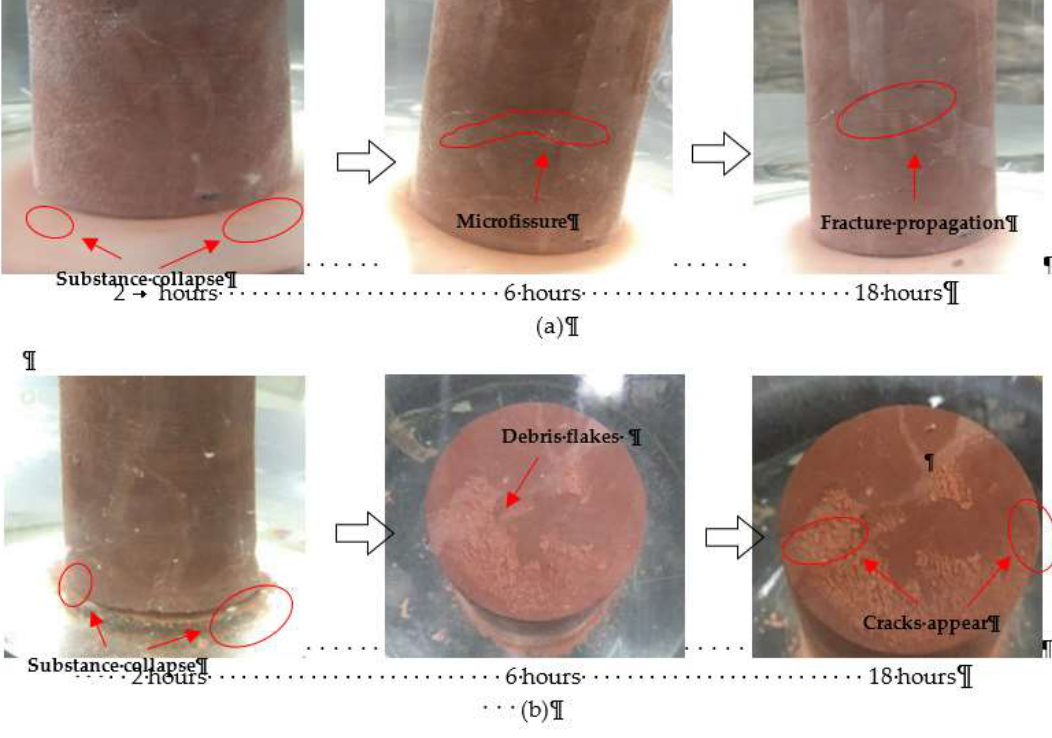
Figure 1. The softening process of soft rock over time under pure water and seawater conditions: ( a ) Pure water immersion; ( b ) Seawater immersion.